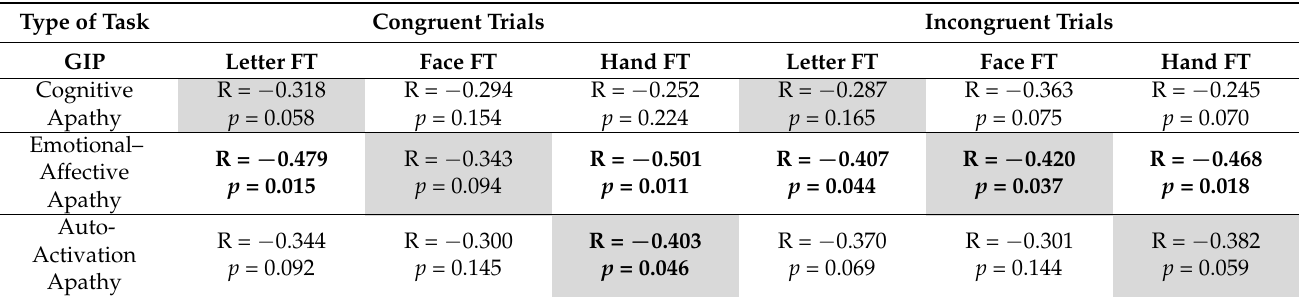
Table 5. Correlations between apathy subtypes and performance of